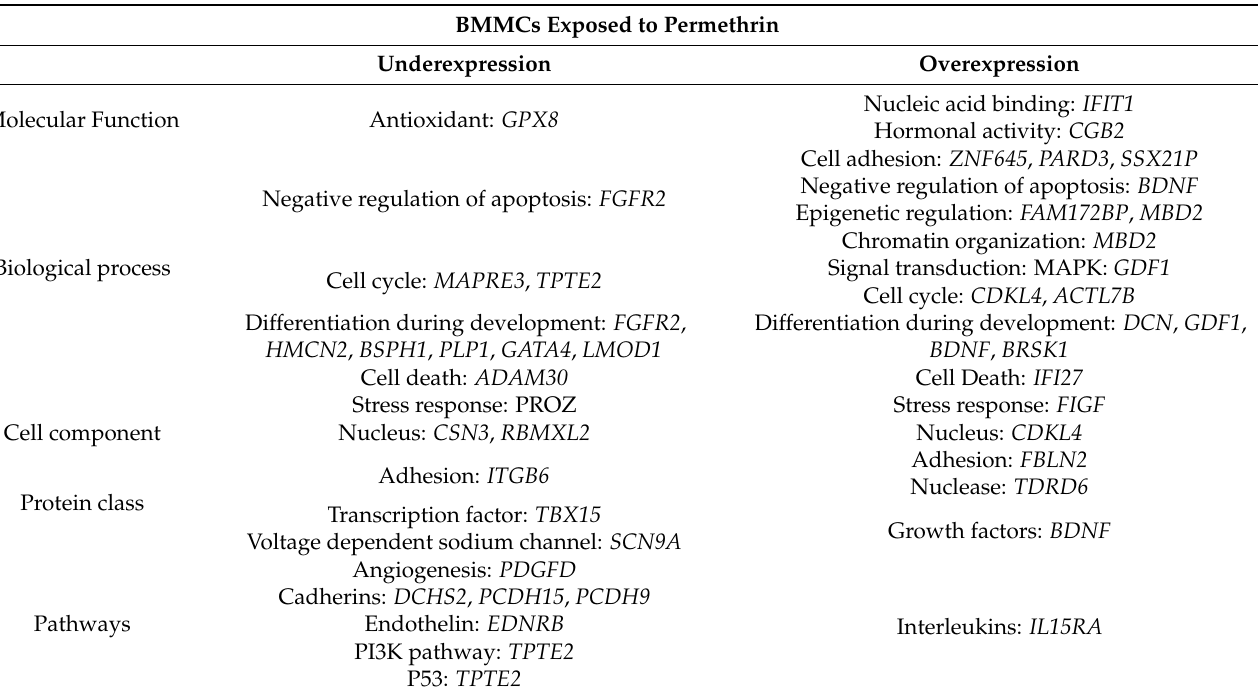
Table 3. Highlights of gene ontology analysis of the top and bottom 100 genes with over and underexpression in BMMCs exposed to